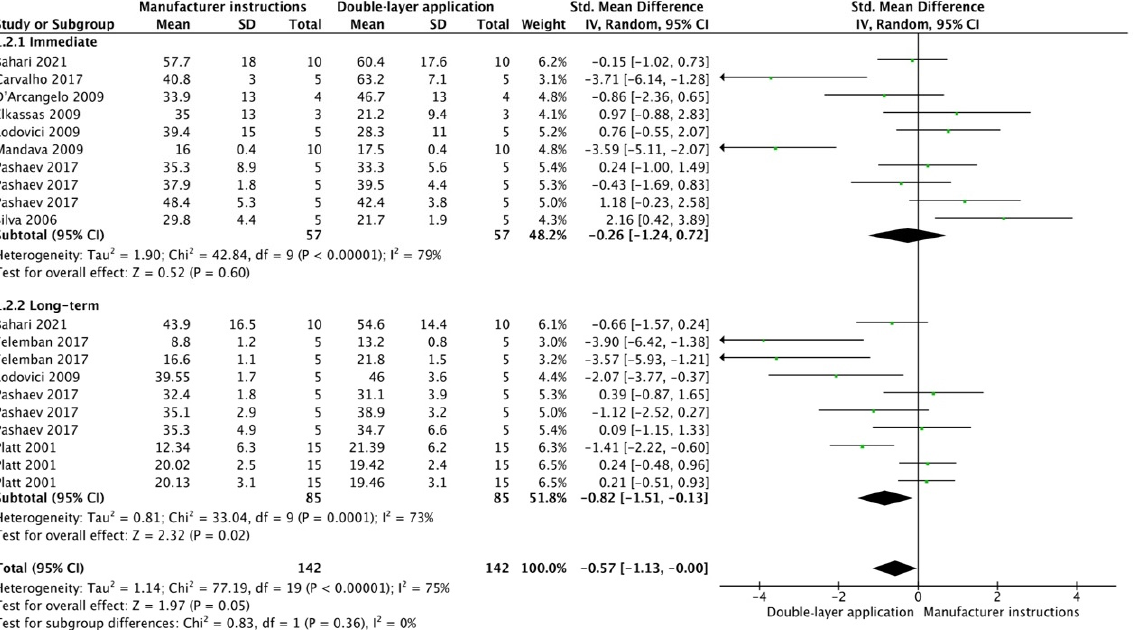
Figure 3. Forest plot showing the bond strength values when the adhesive was applied by extending their application time.